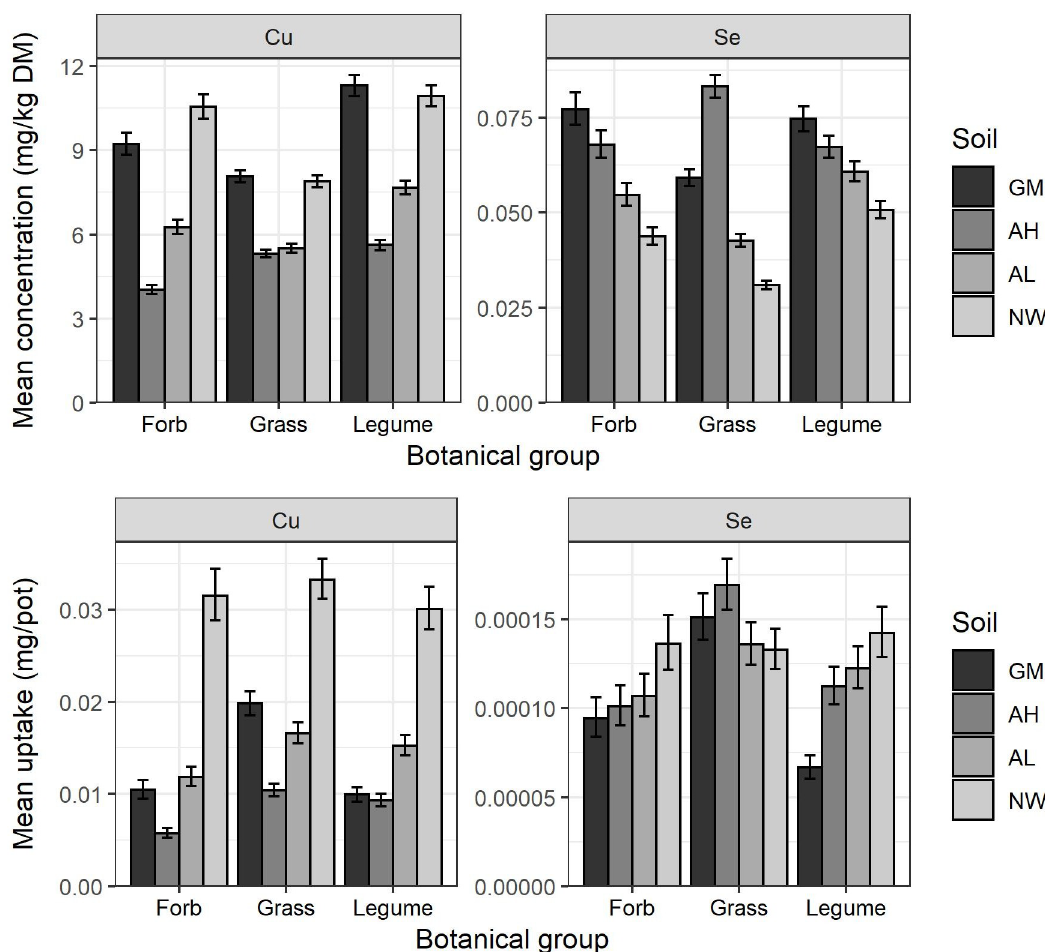
Fig 3. Mean forb, legume and grass Cu concentration and uptake (concentration � plant dry matter yield), and Se concentration and uptake when grown on each of the four soil types: Growing Medium (GM), Arable High pH (AH), Arable Low pH (AL) and North Wyke (NW). Error bars indicate the confidence interval of the back-transformed mean. The least significant difference (LSD) of the back-transformed data were 1.241, 1.421, 1.304 and 1.416 for Cu concentration and uptake and Se concentration and uptake